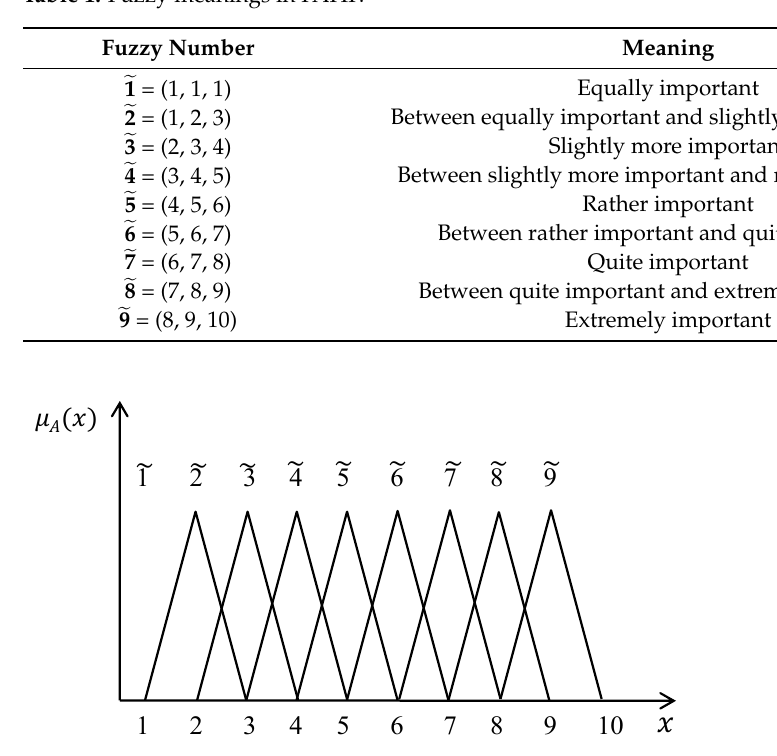
Table 1. Fuzzy meanings in FAHP.